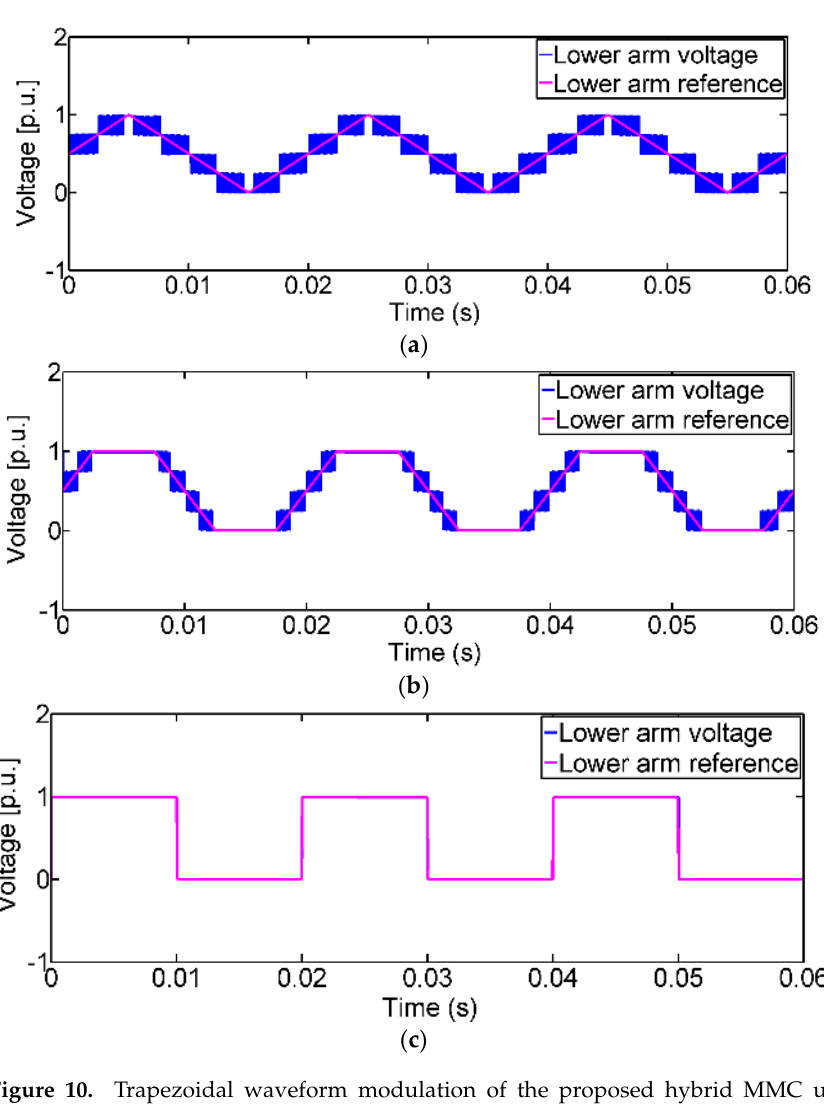
Figure 10. Trapezoidal waveform modulation of the proposed hybrid MMC under different λ : ( a ) λ = 0; ( b ) λ = 0.5; ( c ) λ = 1.